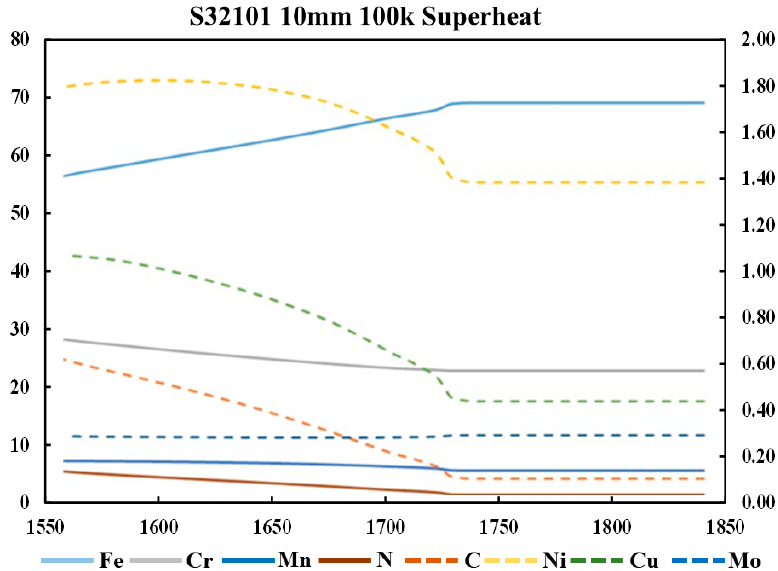
Materials 2022 , 15 , x FOR PEER REVIEW Figure 14. S32101, 100 °C superheated at 10 mm. The liquid phase’s average composition as a tem- Figure 14. S32101, 100 ◦ C superheated at 10 mm. The liquid phase’s average composition as a perature function. Solid lines, left-hand axis; dashed lines, secondary axis. temperature function. Solid lines, left-hand axis; dashed lines, secondary axis.